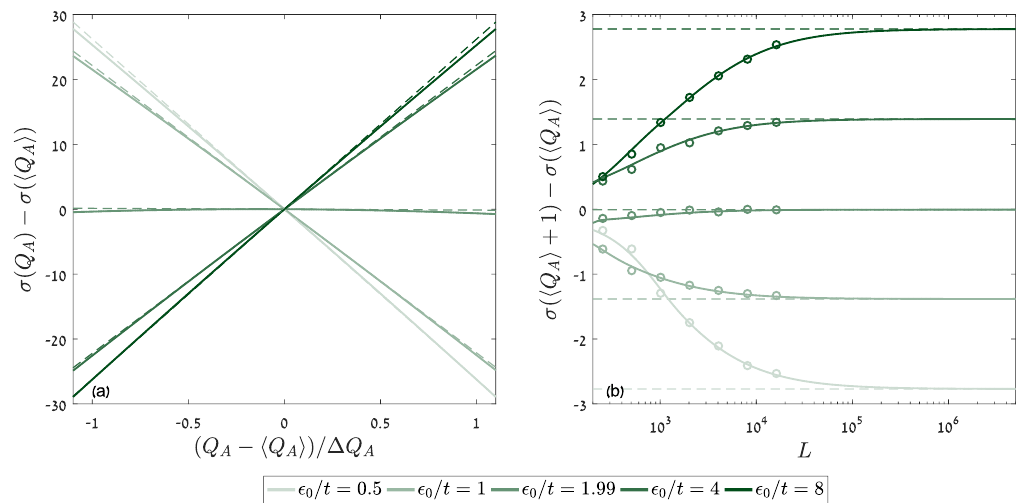
Figure 5: The single impurity model: Breaking of entanglement equipartition by the ) , calculated using Eqs. (5), (19) and (20). Results are post-projection vNEE σ ( Q A / t , with k = π/ 2 and k − k = 0.1. In shown for various fixed values of ε F , R F , L F , R 0 ) is calculated based on the analytically estimated generating function of (a), σ ( Q A 〉 for Eq. (34), and measured relative to its estimated value at the mean charge 〈 Q A a subsystem of L = 10 5 sites (solid lines). Dashed lines designate the corresponding linear equipartition-breaking term that was approximated analytically for large L in ) due to a shift of Q Eq. (50). In (b) we show the difference in σ ( Q in one charge A A 〉 as a function of the length L of subsystem A . σ ( Q ) unit near the mean charge 〈 Q A A is calculated both based on the analytically estimated generating function of Eq. (34) (solid lines), and based on the numerically estimated generating function of Eqs. (17) and (21) (circles; in the numerical case, σ is estimated at the genuine charge sectors 〈 Q 〉 ( int ) and 〈 Q 〉 ( int ) + 1 rather than at 〈 Q 〉 and 〈 Q 〉 + 1). Dashed lines designate A A A A the L -independent slope of the linear equipartition-breaking term in Eq.